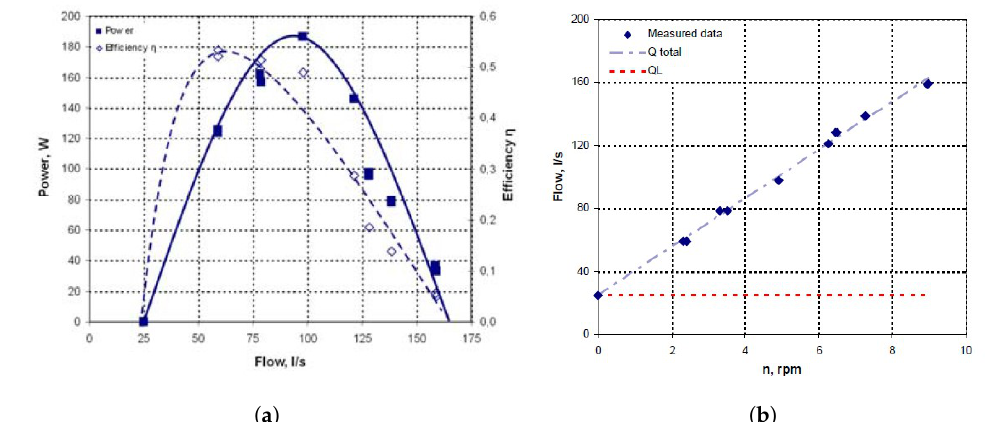
Figure 3. Operational curves of the HPM of medium-scale and radial straight blades tested in the HYLOW project (taken from [38]). ( a ) shows Power—Discharge and Efficiency—Discharge curves while ( b ) shows the relationship between discharge and rotating speed.